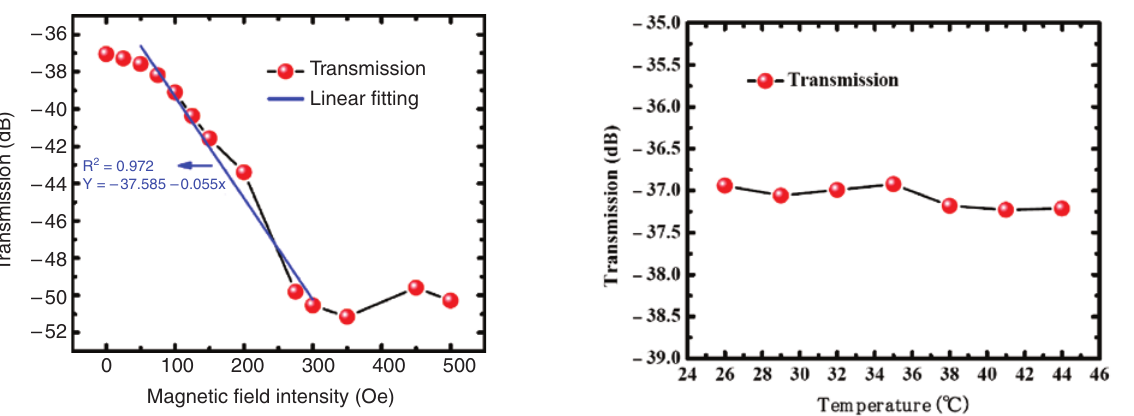
Figure 7: Transmission loss of Dip A as a function of environmental when temperature changes from 26 ° C to 44 °